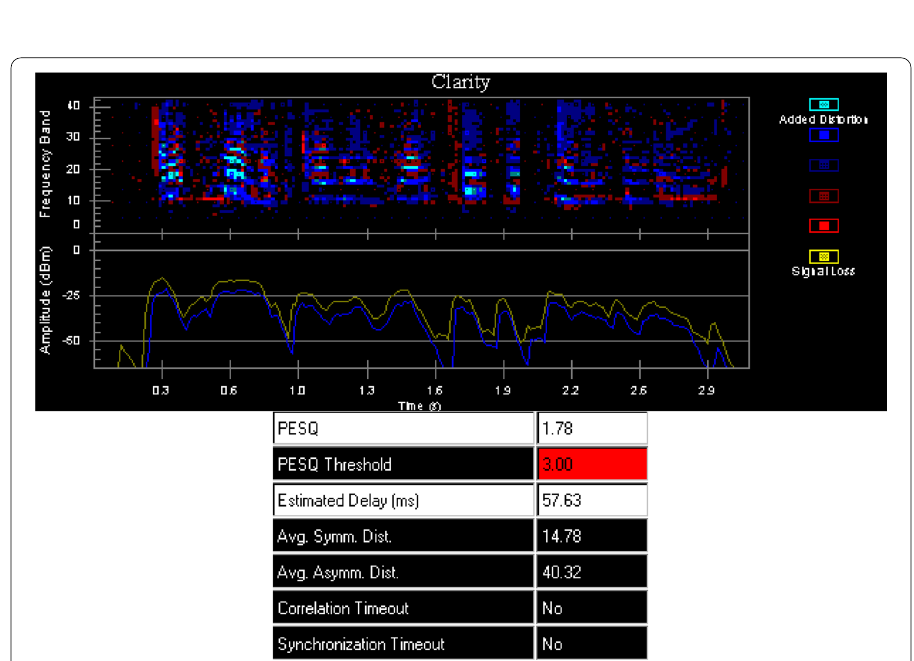
Fig. 17 2-D Error surface clarity test